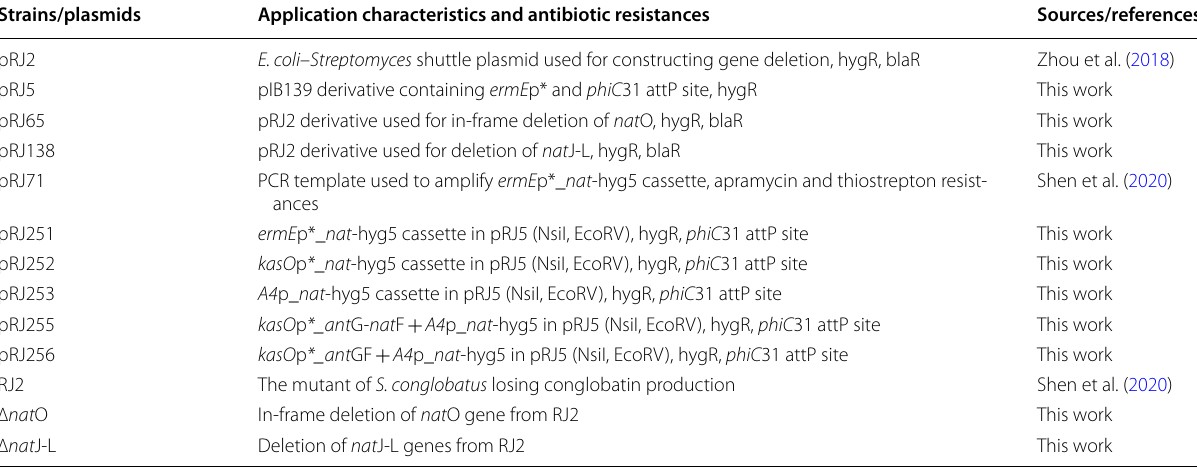
hygR , hygromycin resistance, blaR , ampicillin resistance